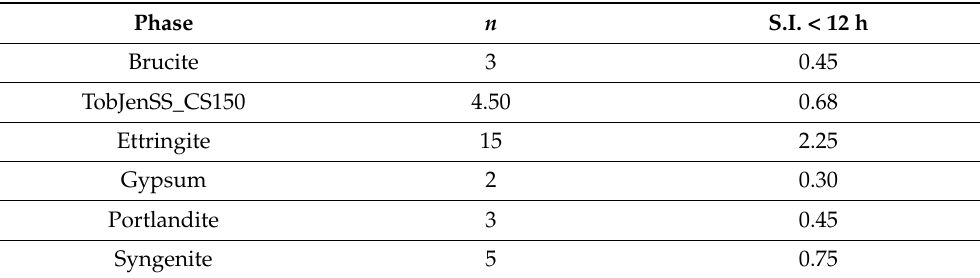
Table 6. Number of charged species ( n ) involved in the dissolution reaction of brucite, Tob- JenSS_CS150, ettringite, gypsum, portlandite and syngenite phases to account for oversaturation (S.I. = 0.15 · n ) during the first 12 h of OPC hydration. Phase n S.I. < 12 h Brucite 3 0.45 TobJenSS_CS150 4.50 0.68 Ettringite 15 2.25 Gypsum 2 0.30 Portlandite 3 0.45 Syngenite 5